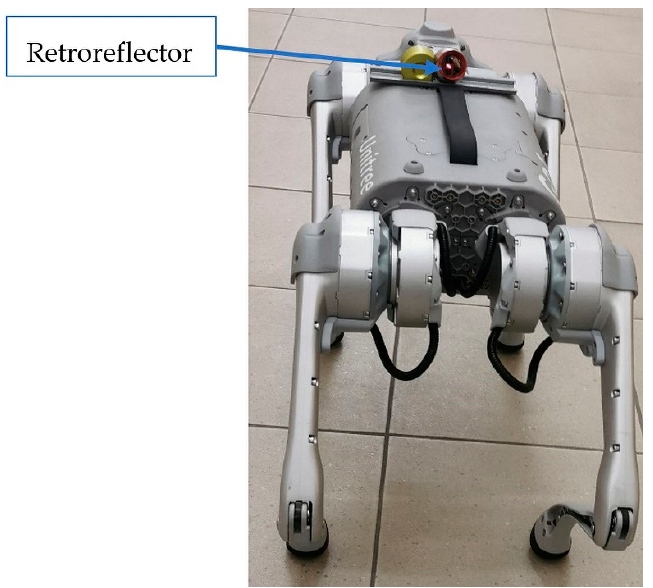
Figure 14. UNITREE 4-legged GO1 robot.